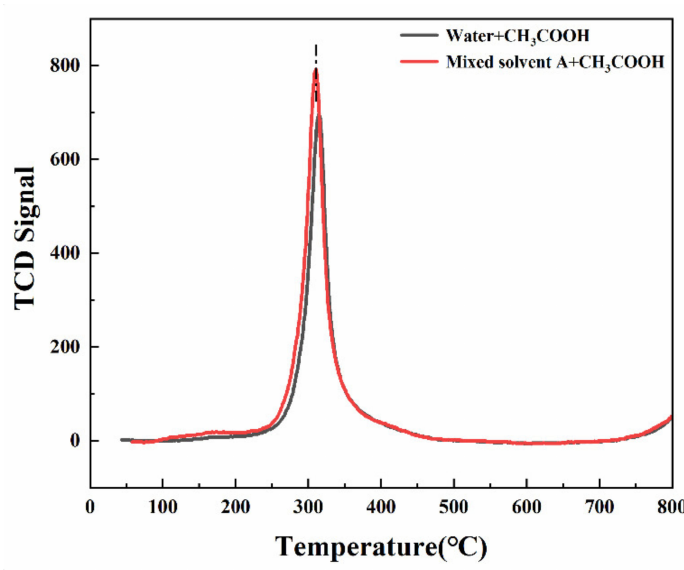
Figure 7. TPD results of the catalysts prepared using water and mixed solvent A as the